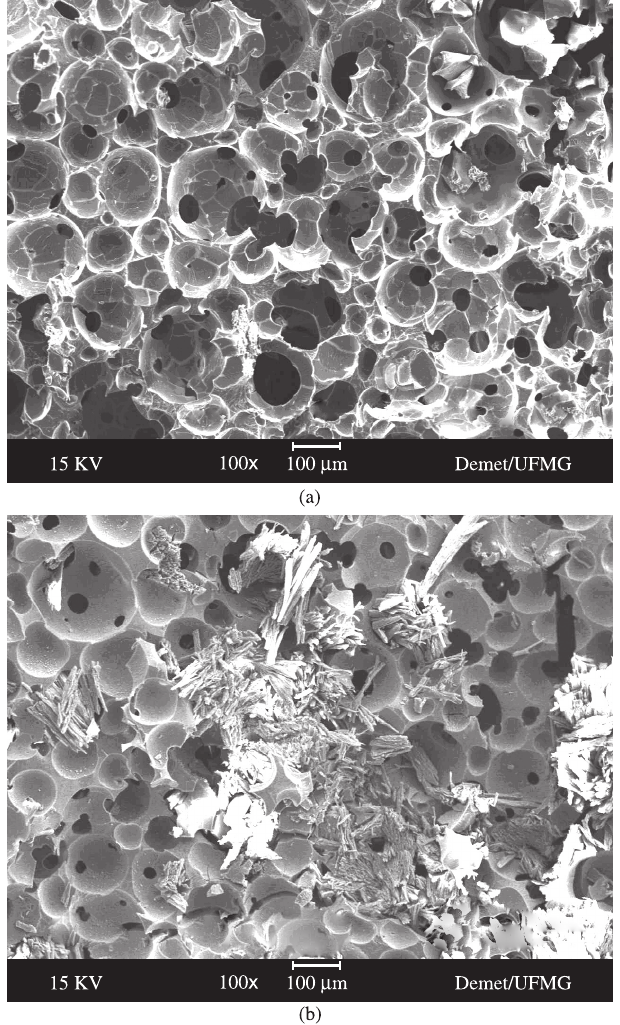
Figure 5. SEM images, increased 100 x , of hybrid foams with 20 wt. (%) PVA contend, (a) before and (b) after calcium acetate neutralization method.